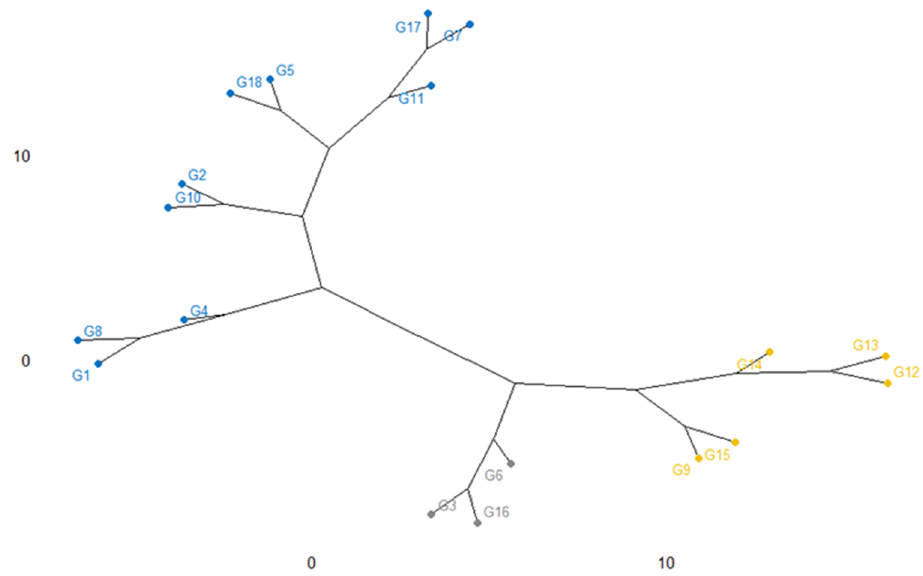
Figure 9. Cluster analysis showing the genotypic diversity and relevancy along with the 18 salinity tolerant rice genotypes based on yield traits.